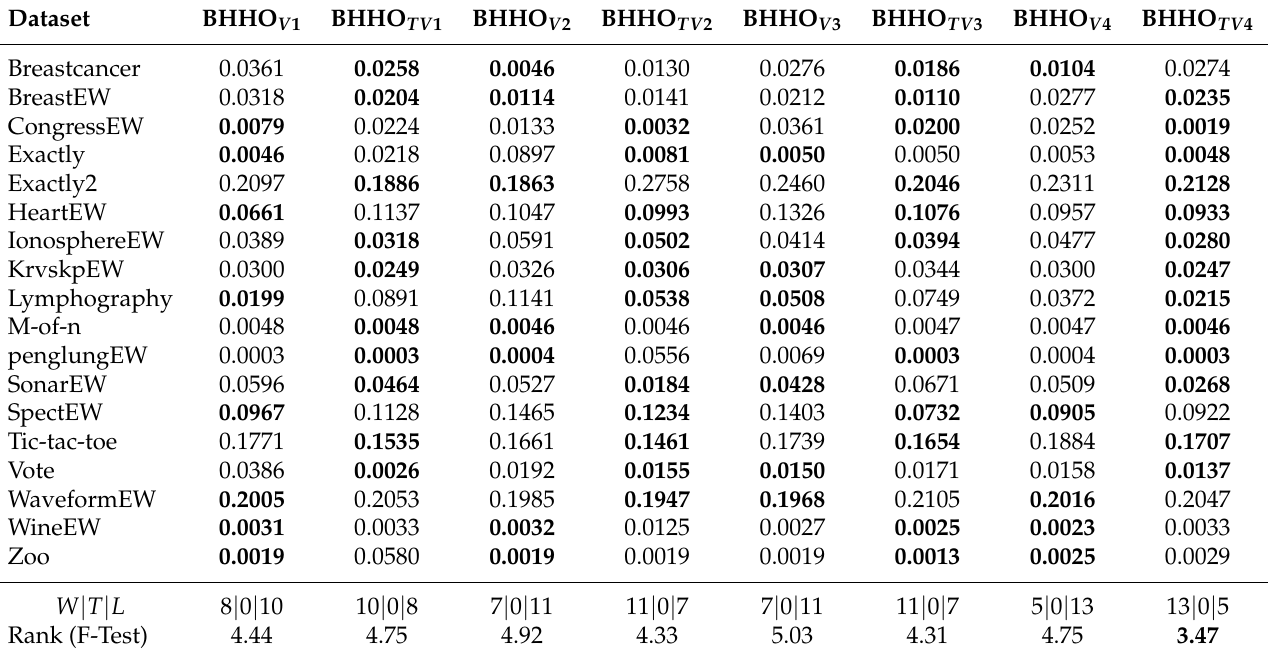
Table 6. Comparison of BHHO with the basic and time-varying V-shaped variants in terms of fitness rates.